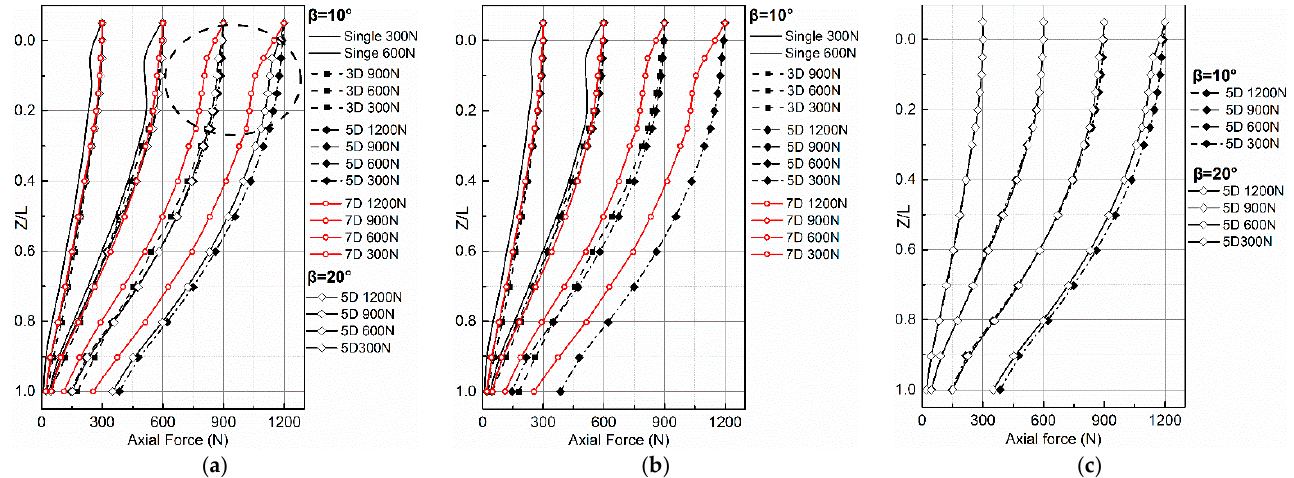
Figure 8. The variation in axial force along depth: ( a ) axial force of all tests, ( b ) axial force when β = 10°, and ( c ) axial force β = 10° vs. β = 20.